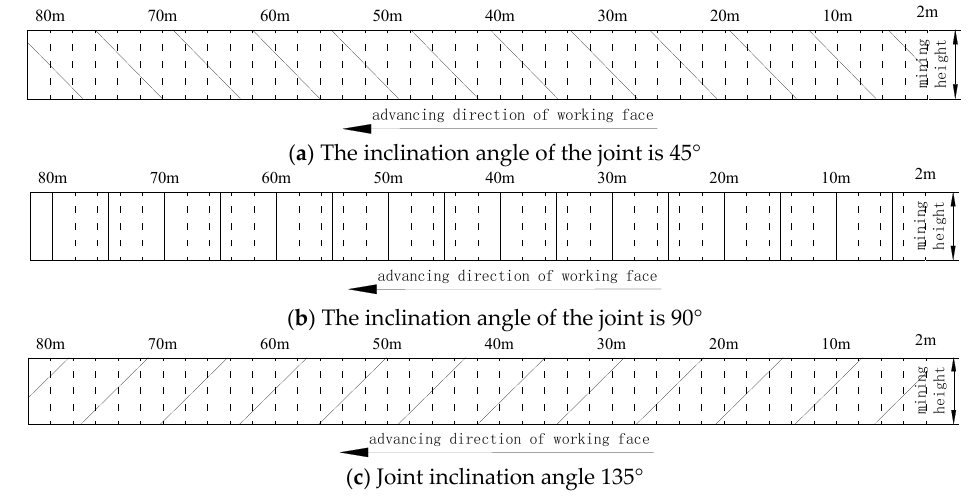
Figure 6. Model section of joint surfaces with different inclination angles in hard coal seam (the dotted line is the excavation step).